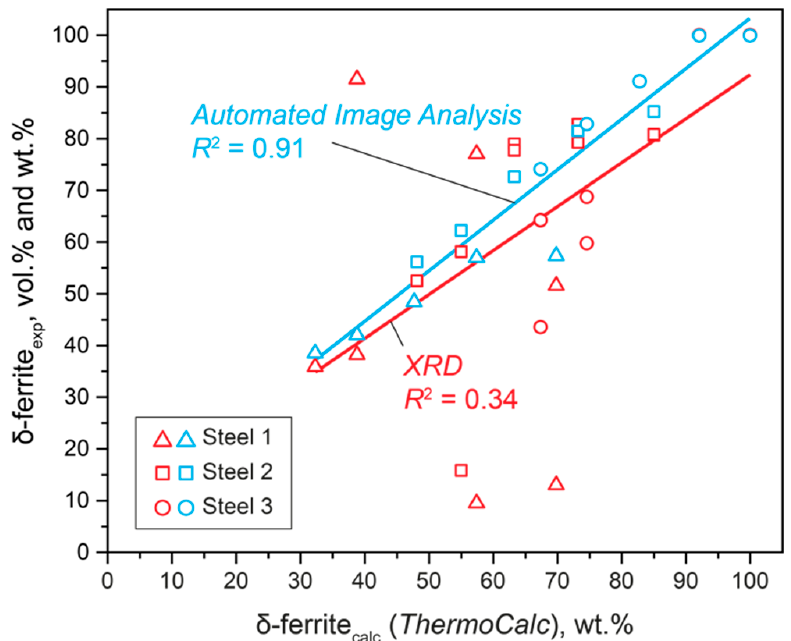
Figure 2. Comparison of phases volume fraction estimation methods. The σ -phase formation leads to the strengthening of DSSs and to a simultaneous de- crease in corrosion properties. Figure 3 shows the microstructure of a Steel 4 specimen after provoke annealing at 850 ◦ C and revealed using the Beraha’s reagent (reagent 4, Table 2), which showed the best result discussed earlier in identifying ferrite and austenite.